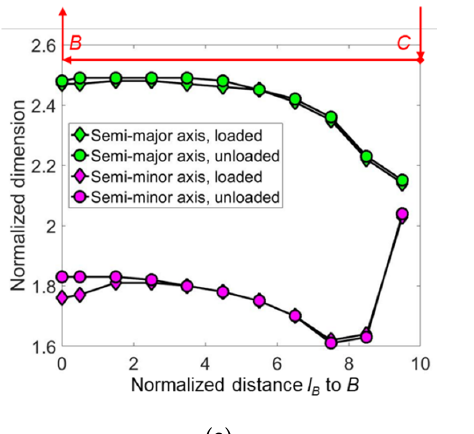
Figure 15. The fitted ( a ) dimension and ( b ) depth of the elastic–plastic boundary normalized by h max . The indenter moves from the point C to the point B in the scratching stage (see Figure 2).